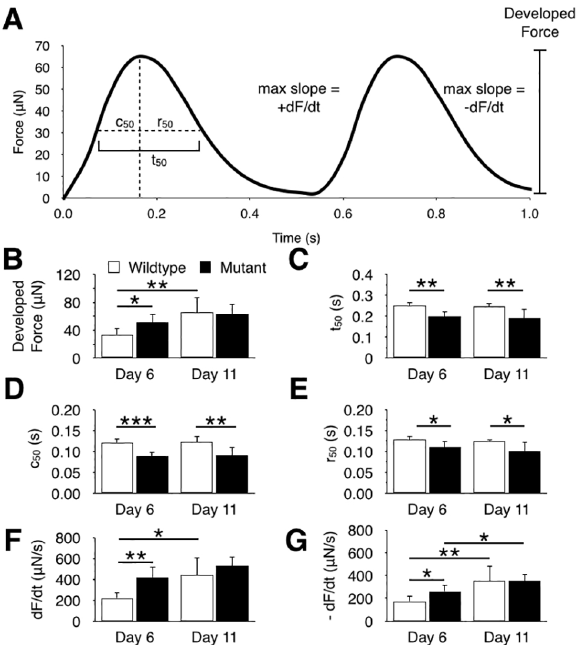
Fig 2. Twitch force characteristics of wild-type and BRAF-mutant hECTs. ( A ) Cartoon of iPSC-derived hECT force data illustrating twitch characteristic parameters. ( B-G ) Mean ( ± SD) twitch parameters for wild- type (open bars, n = 7) and BRAF mutant (solid bars, n = 5) iPSC-hECTs tested on culture days 6 and 11, including developed force ( B ), 50% twitch duration ( C ), time to 50% contraction ( D ), time to 50% relaxation ( E ) and the maximum rates of contraction ( F ) and relaxation ( G ). * p < 0.05, ** p < 0.01, *** p <